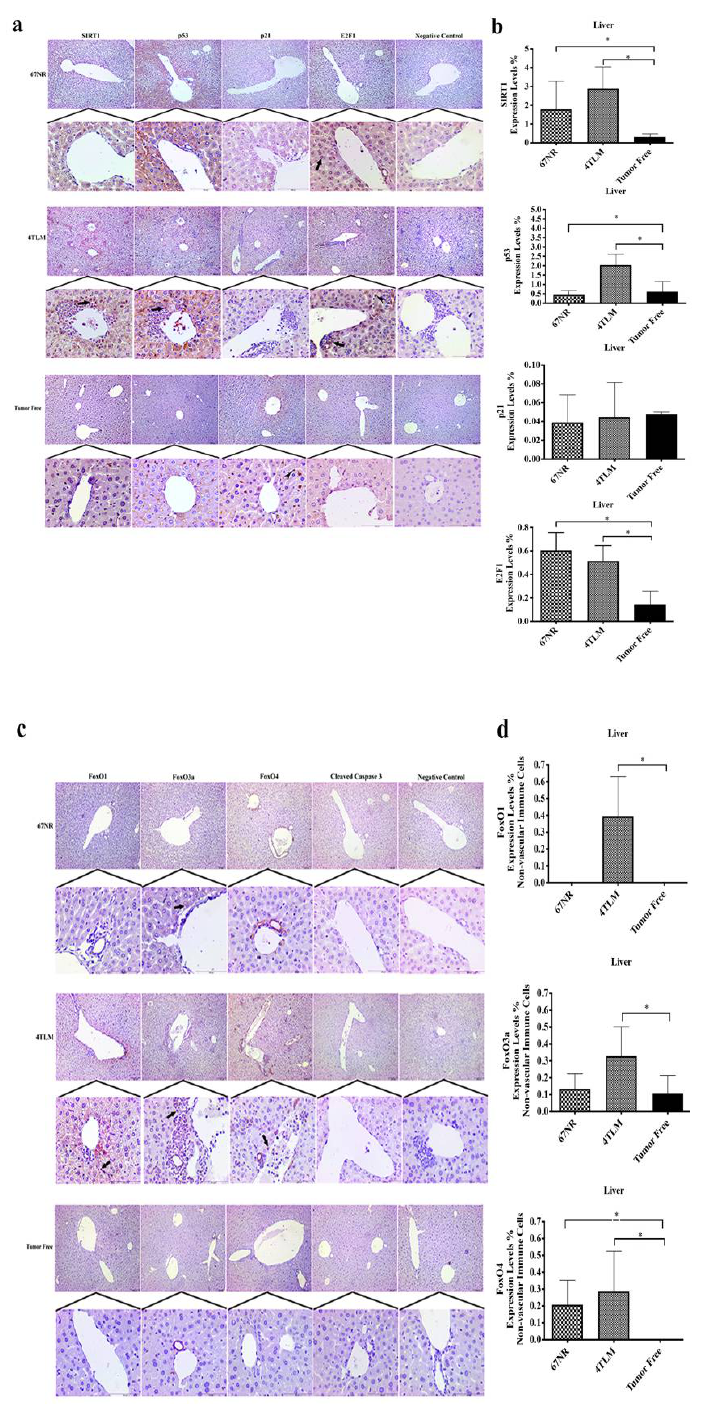
Figure 3. ( a ) Representative figures of SIRT1, p53, p21 and E2F1 immunohistochemical staining of liver tissues. Immunohistochemical reactions were interpreted compared to animals injected with both metastatic and non-metastatic cell lines, in addition to tumor-free animals. Arrows represent target protein expression for each protein in infiltrated cells, and arrowheads represent Kupffer cells. Scale bar represents 100 µ m. ( b ) Graphs demonstrate the results of Image J analysis for each protein in liver tissues (* p < 0.05). ( c ) Representative images of FoxO1, FoxO3a, FoxO4 and cleaved caspase 3 protein immunohistochemical staining of liver tissues. Arrows represent target protein expression for each protein in infiltrated cells. Scale bar represents 100 µ m. ( d ) Graphs show the results of Image J analysis for each protein in liver tissues (* p <